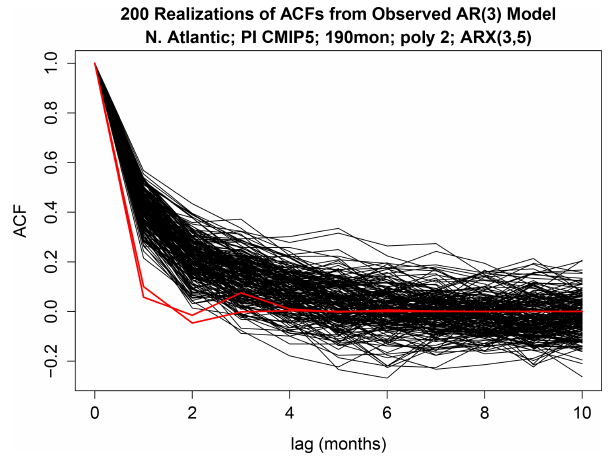
Figure 12. Two-hundred realizations of the sample autocorrelation function from the ARX(3,5) estimated from observations (black curves), and the autocorrelation function for CNRM-CM5 (red), which was found to differ significantly from observations.